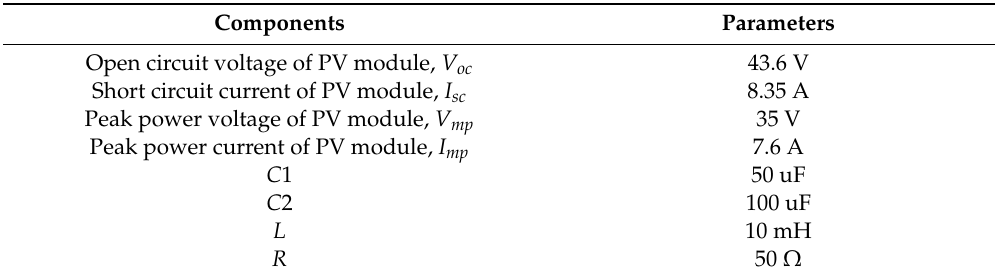
Table 1. Parameters of simulation components.